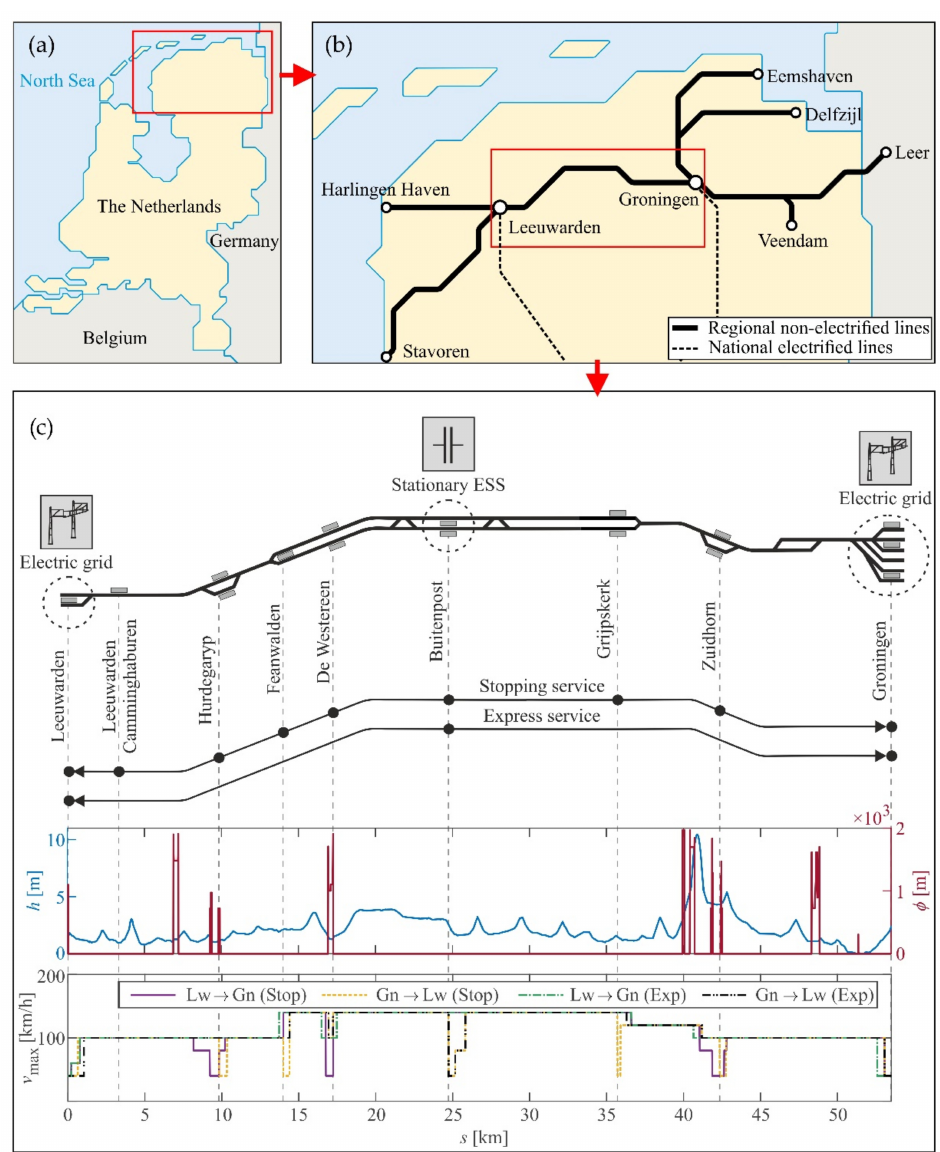
Figure 8. ( a ) Position and ( b ) schematic representation of the Northern lines in the Netherlands; and ( c ) track layout for the railway line Leeuwarden-Groningen with indicated locations for charging facilities, stops for stopping and express service, track geometry, and maximum allowed